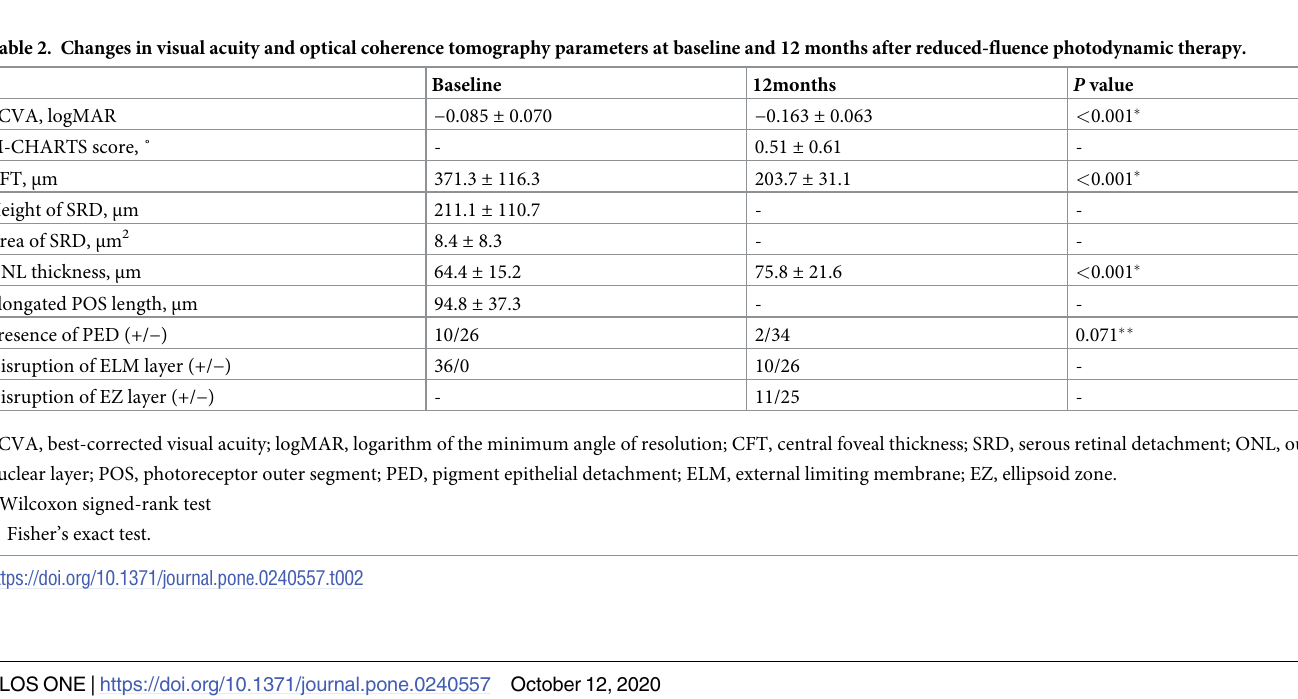
Table 2. Changes in visual acuity and optical coherence tomography parameters at baseline and 12 months after reduced-fluence photodynamic therapy. Baseline 12months P value − 0.085 ± 0.070